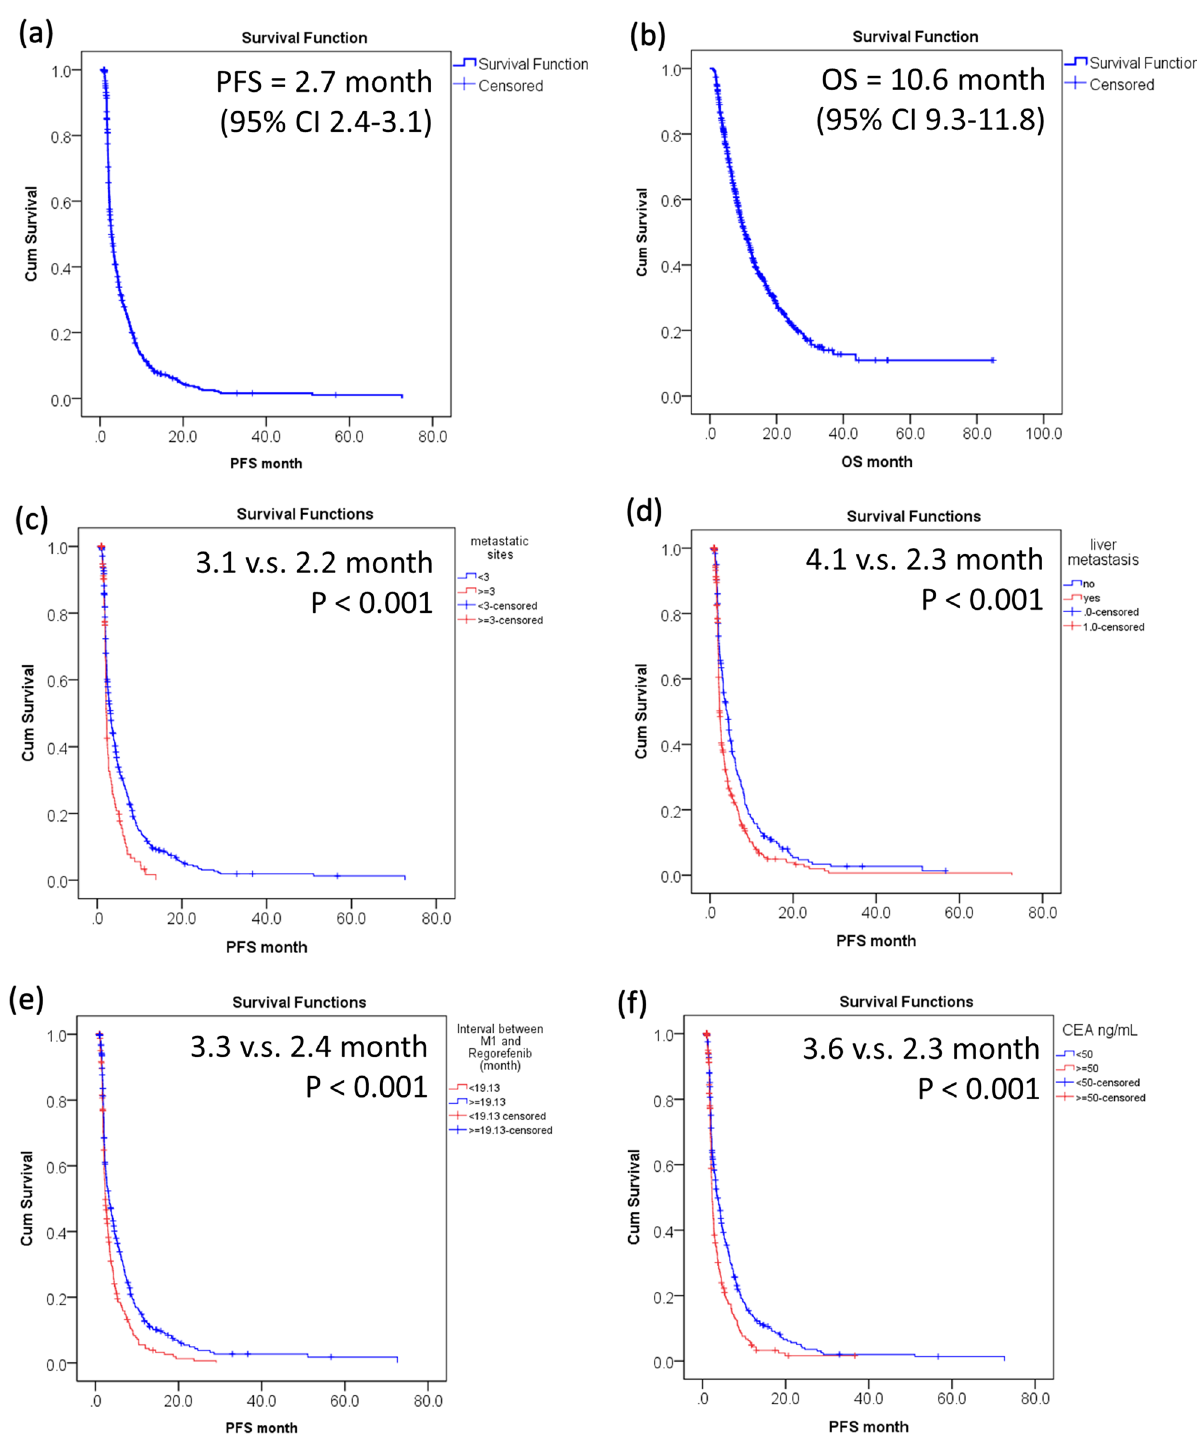
Figure 1. Kaplan–Meier curves for ( a ) progression-free survival (PFS); ( b ) overall survival (OS); ( c ) PFS by metastatic sites; ( d ) PFS by liver metastasis; ( e ) PFS by interval between M1 and regorafenib; ( f ) PFS by Carcino Embryonic Antigen (CEA)